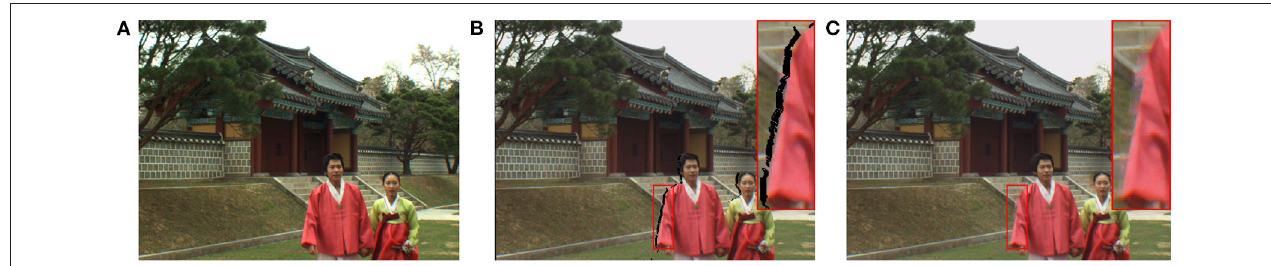
FIGURE 1 | Examples of the local geometric distortion and the color deviation distortion in the synthesized images. (A) is the ground-truth image. (B,C) are the synthesized images, which includes the local geometric distortion and the color deviation distortion compared to the ground-truth